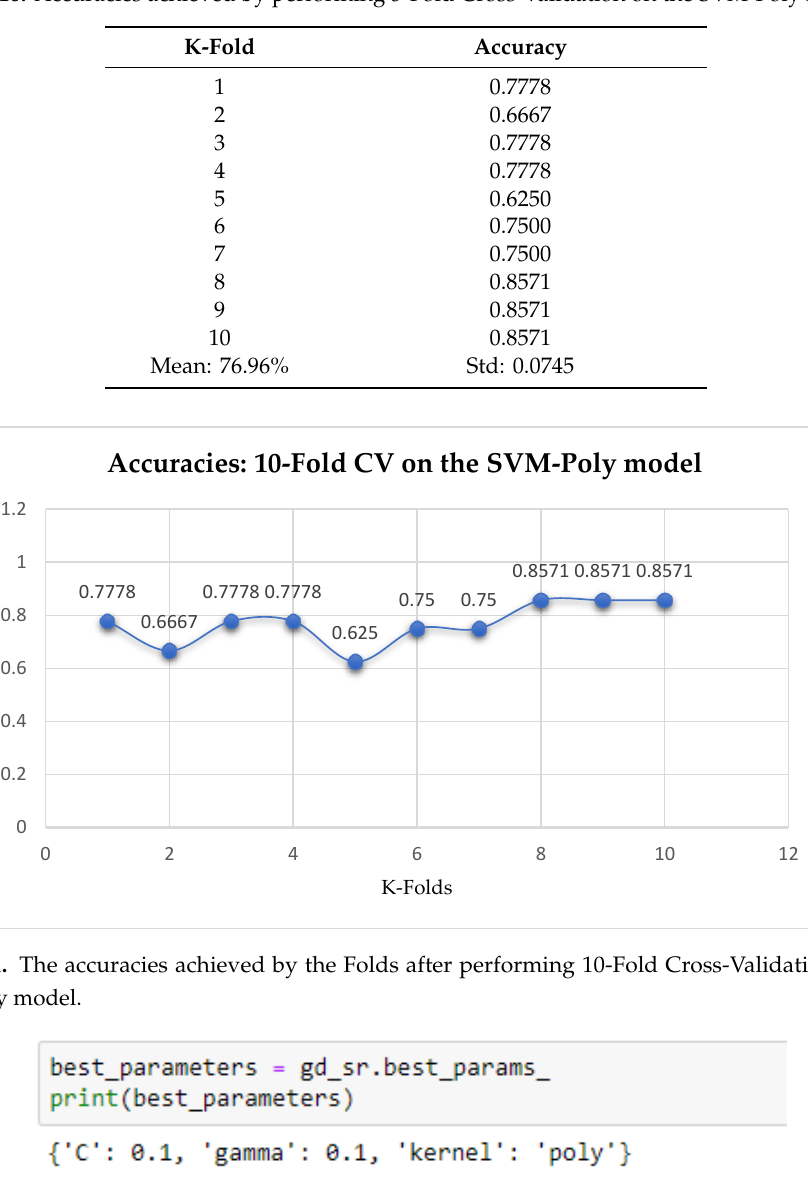
Table 10. Accuracies achieved by performing 5-Fold Cross-Validation on the SVM-Poly model.